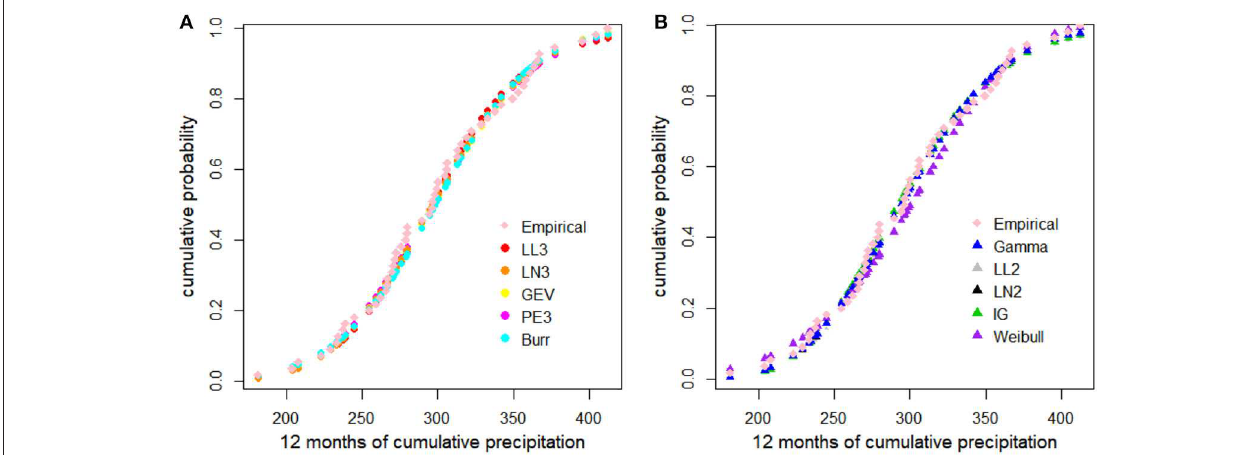
FIGURE 2 | Cumulative probability for 12-month cumulative precipitation in January at Tuole station (LL3, LL2, LN3, LN2, GEV, PE3, and IG represent the three- and two-parameter log-logistic and log-normal, generalized extreme value, Pearson-III, and inverse Gaussian distributions, respectively). (A) The cumulative probability of empirical and three-parameter theoretical distributions. (B) The cumulative probability of empirical and two-parameter theoretical distributions.